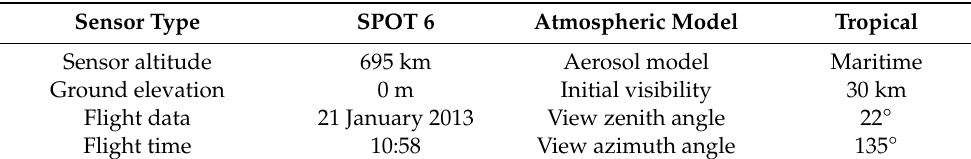
Table 4. Input parameters in fast line of sight atmospheric analysis of spectral hypercube (FLAASH).